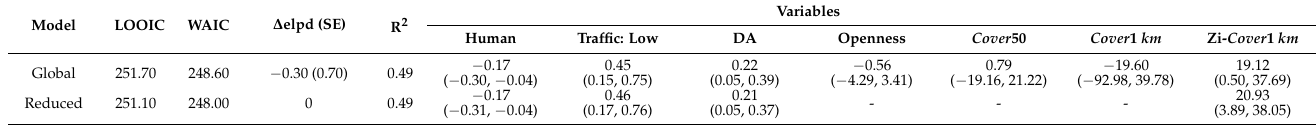
presented by the solid line, and the vertical dashed line indicates the value of 0. The color blue means